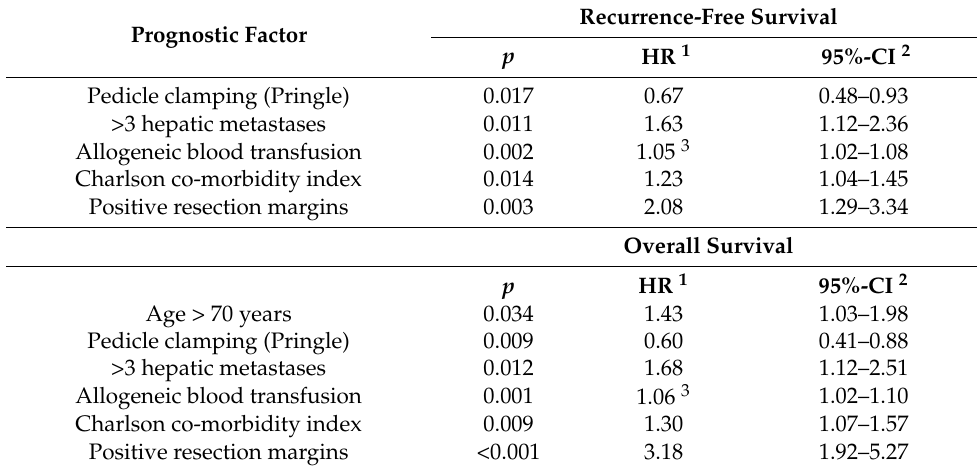
Table 2. Multivariable analysis of recurrence-free and overall